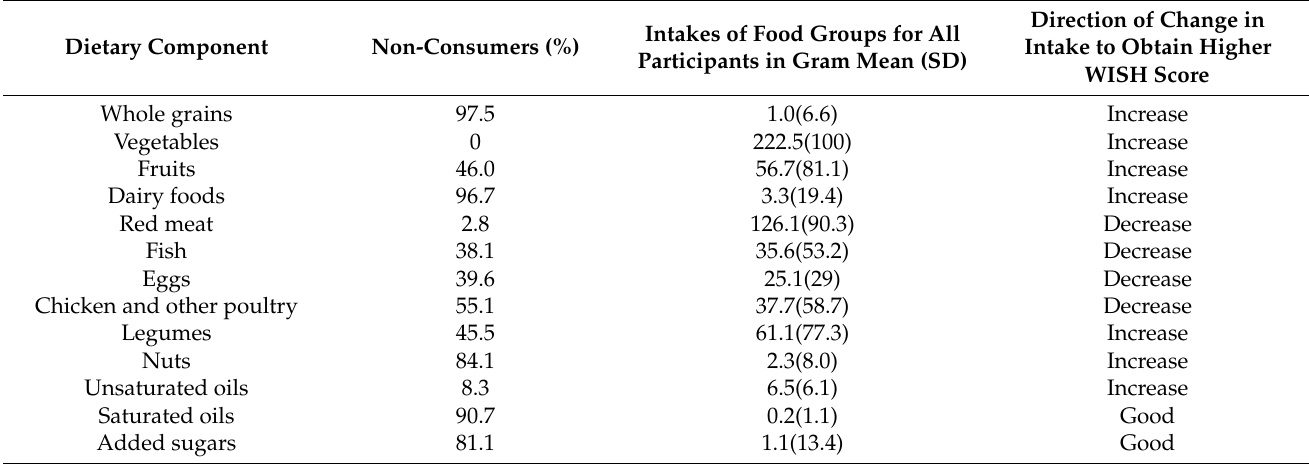
Table 2. Components consumption and WISH